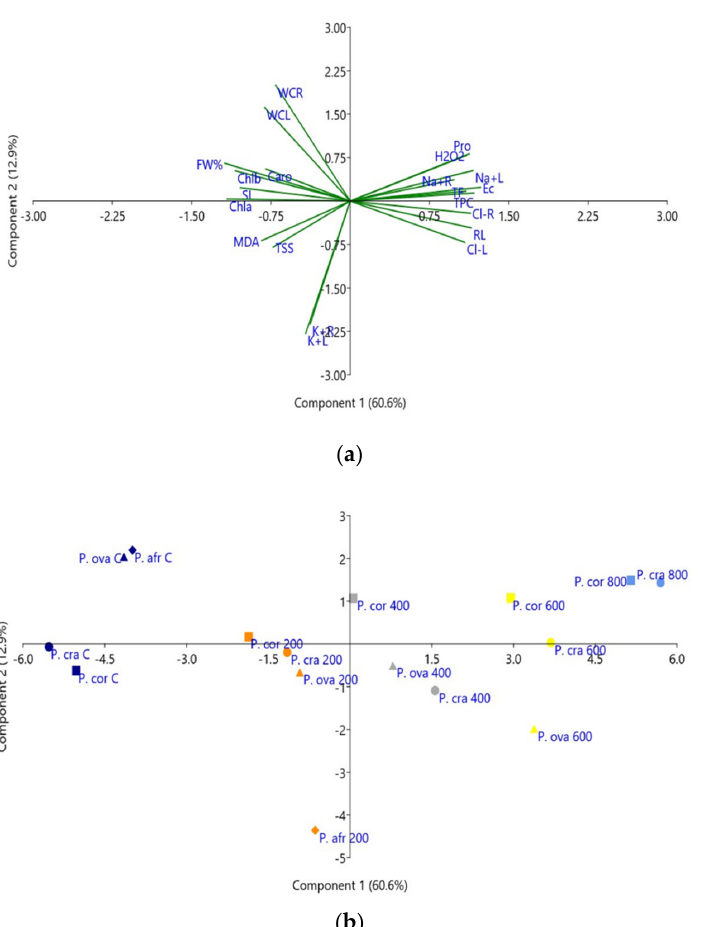
Figure 9. Loading plot of the principal component analysis (PCA) ( a ), and scatterplot of the PCA score ( b ), including all analysed traits in P. coronopus (P. cor), P. crassifolia (P. cra), P. ovata (P. ova) and P. afra (P. afr) subjected to treatments with 0 (control, C), 200, 400, 600 and 800 mM NaCl, for four weeks. The first and second principal components accounted for 60.6% and 12.9% of the total variation, respectively. Abbreviations: electrical conductivity of substrate (EC); root length (RL); stem length (SL); root water content (RWC); leaf water content (LWC); fresh weight of leaves (FW%); chlorophyll a (Chla) chlorophyll b (Chlb); total carotenoids (Caro); sodium content in leaves and roots (Na+L; Na+R); chloride content in leaves and roots (Cl-L; Cl-R); potassium content in leaves and roots (K+L; K+R), total soluble sugars (TSS), malondialdehyde (MDA), hydrogen peroxide (H2O2); proline (Pro); total phenolic compounds (TPC) and flavonoids (TF).